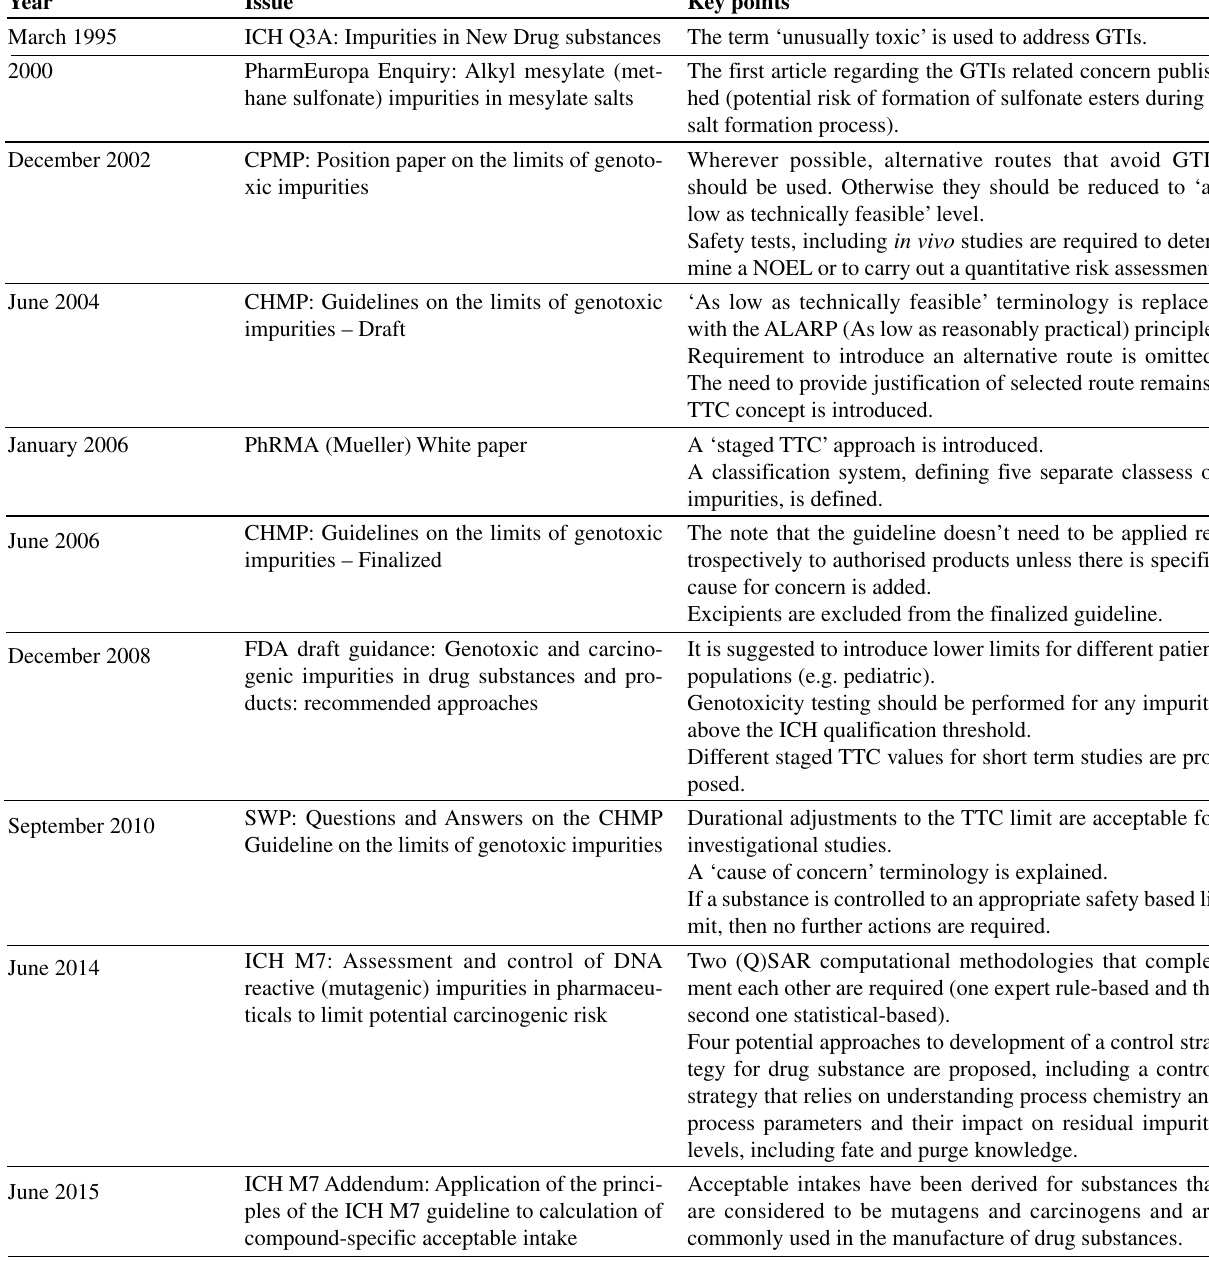
Table 2: A brief history of development of GTIs guidelines (based on Teasdale 5 and Szekely et al. 24